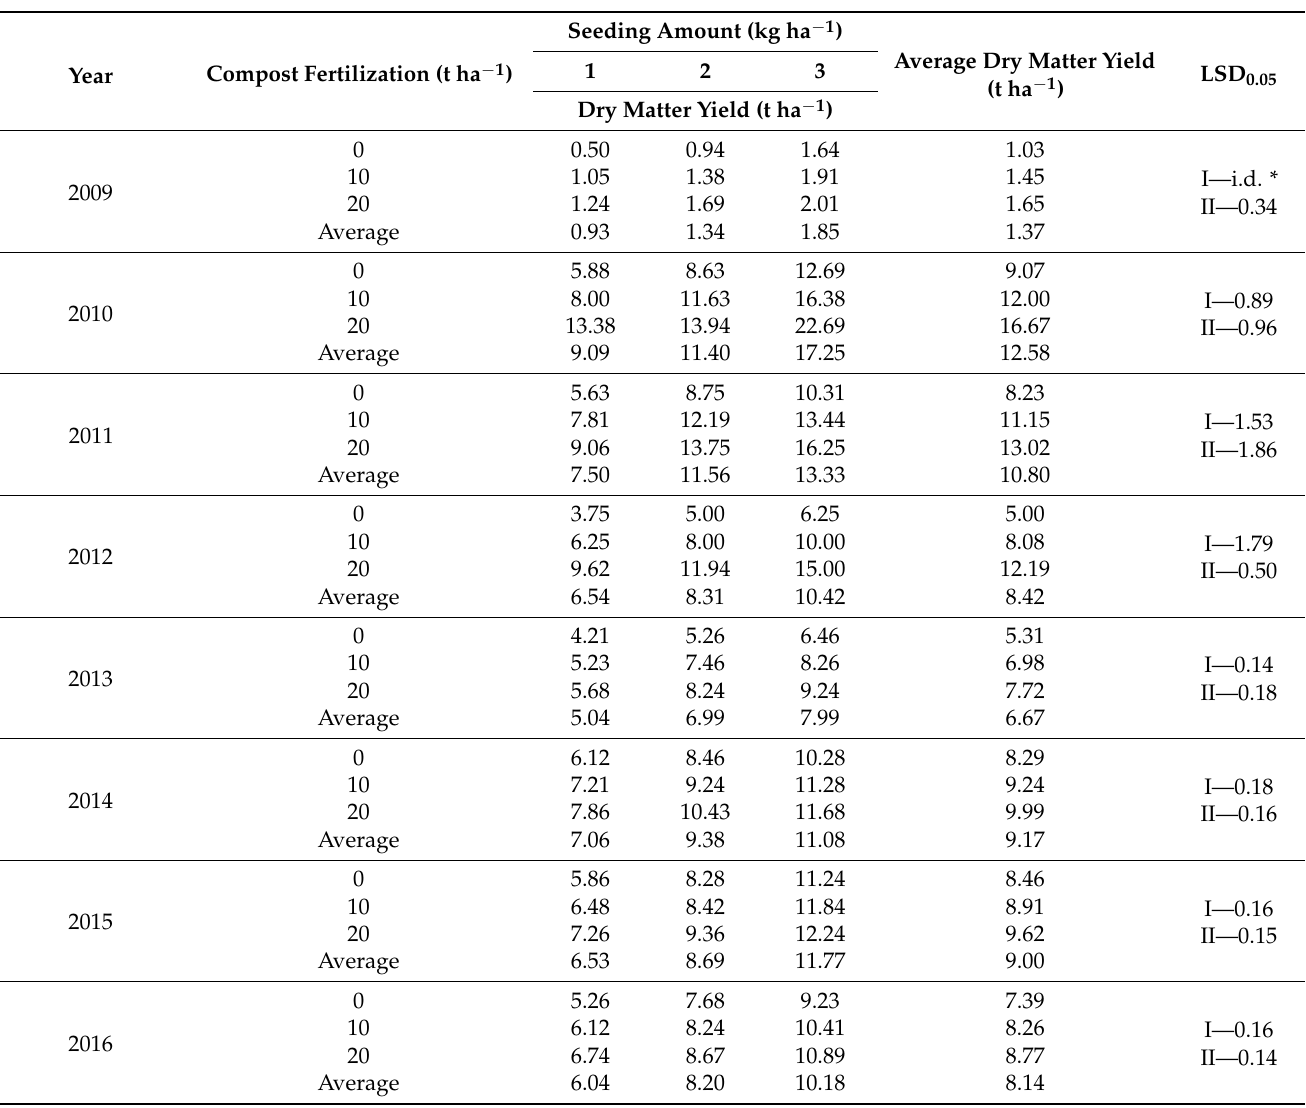
Table 7. Effects of seeding amount and fertilization with compost on the DMY (t ha − 1 ) of Sida during the years of